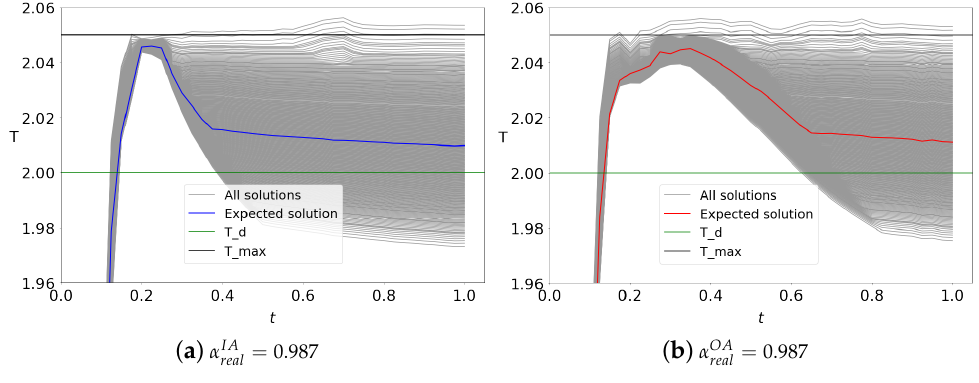
( t , x ) , ξ ) , i = 1, . . . , N (all solutions) and i , t , x ( ˆ t 1 ,ˆ t 1 + H (cid:48) ]